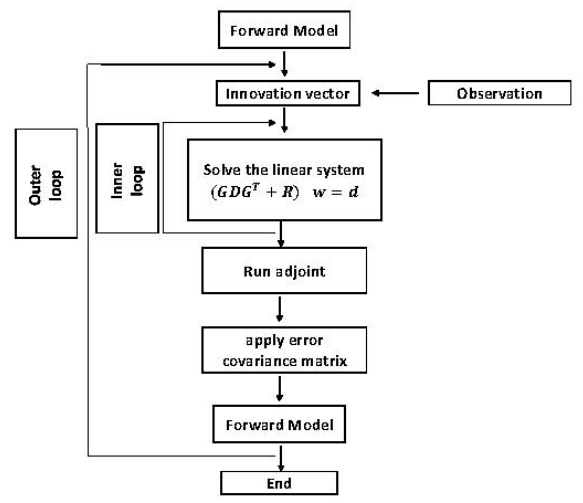
Figure 1. A flow chart illustrating the data assimilation algorithm.